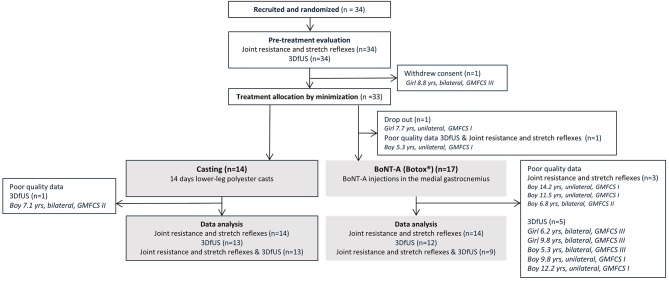
Overview of statistical analyses. 3DfUS, 3D freehand ultrasound; BoNT-A, Botulinum NeuroToxin-A.